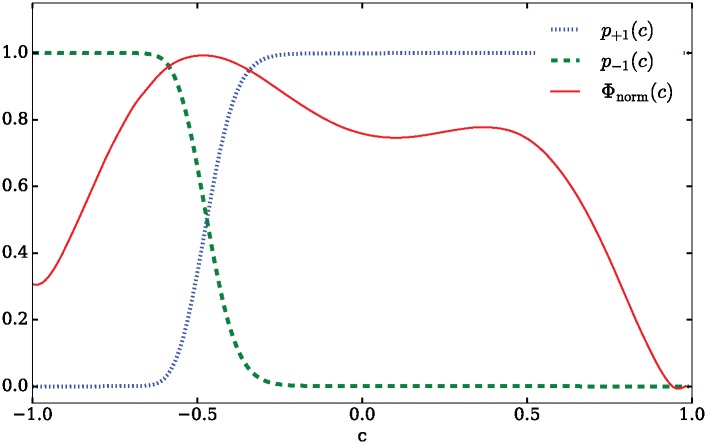
FPE potential.Φnorm ≡ (Φ − min[Φ])/(max[Φ] − min[Φ]), and splitting probabilities p±1(c) of the temporally homogeneous process.